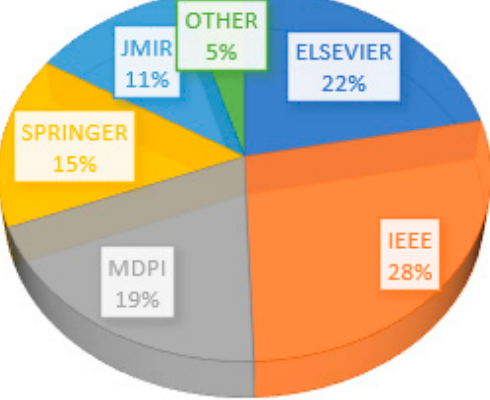
Figure 5. Results distribution by publisher.